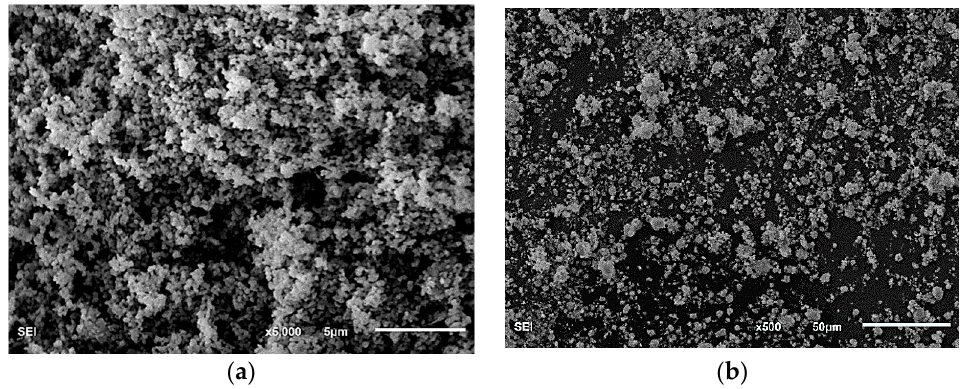
Figure 2. Typical scanning electron microscopy images of as-received zirconia particles: ( a ) coarse and ( b ) fine.